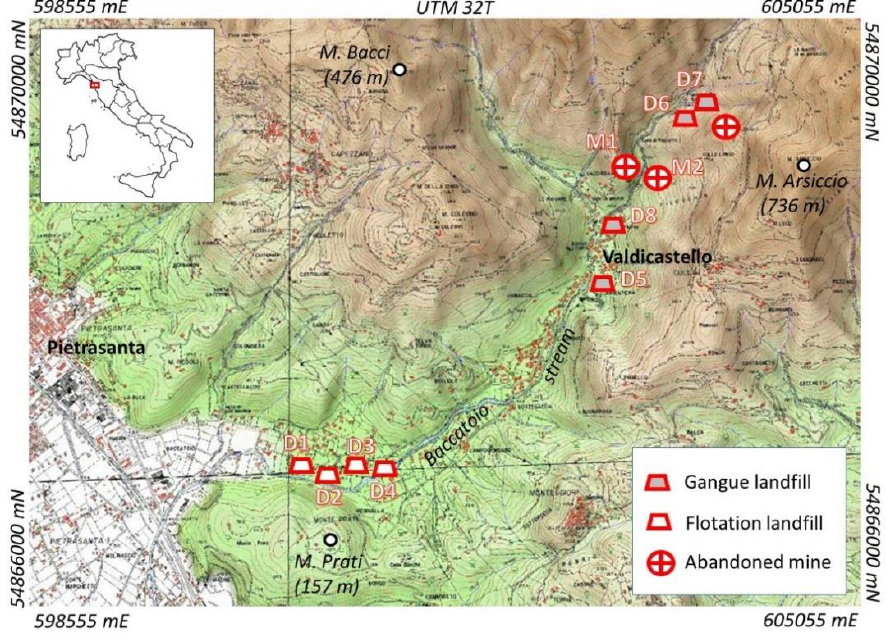
Figure 1. Map of the study area and georeferenciated sampling sites (WGS-84 UTM 32T coordi-